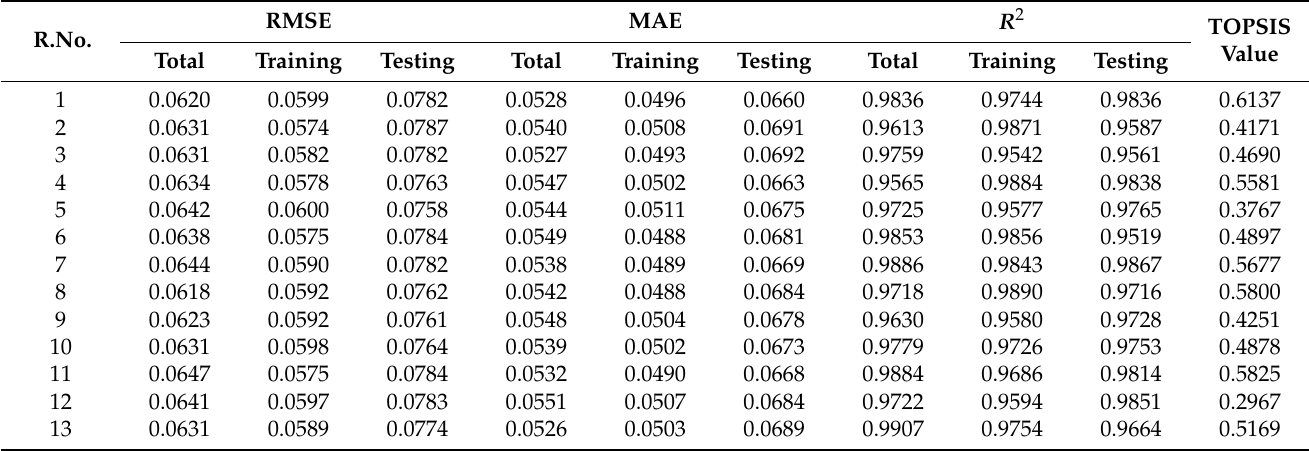
Table 7. Performance of SVR model for crack depth (D) using MFO